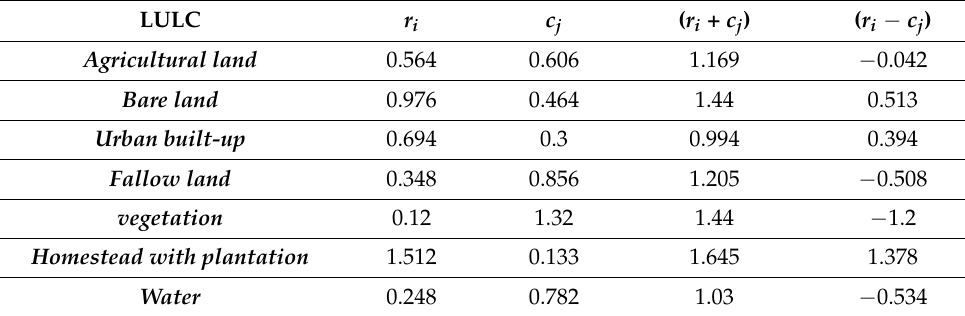
Table 19. Cause and effect chain calculated from DEMATEL